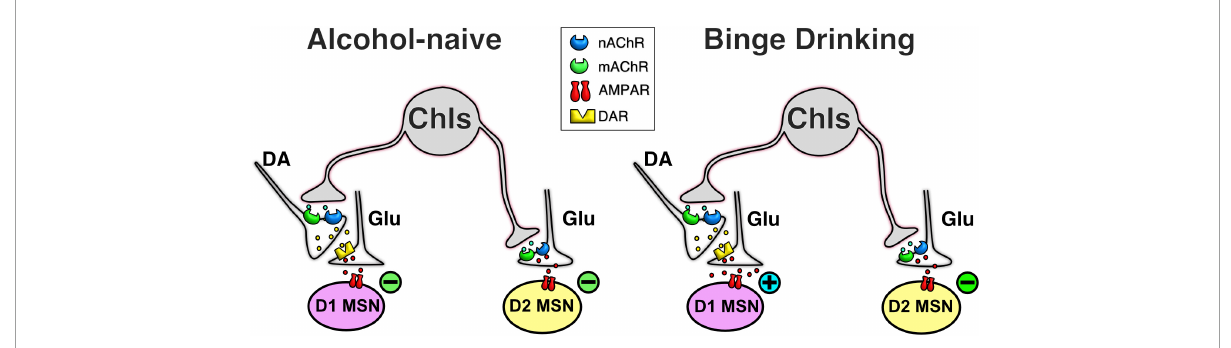
FIGURE8 Simplified schematic of ChI effect on glutamatergic neurotransmission in MSNs in naïve and alcohol binge drinking mice. In D1-MSNs of naïve mice, ChIs decrease glutamatergic neurotransmission presynaptically through the release of DA in D1-MSNs (top left cartoon) , an effect that is reversed in DID mice (top right cartoon) . In contrast, in D2-MSNs of naïve mice, ChIs directly control glutamate release from terminals synapsing on D2-MSNs (bottom left cartoon) , an effect that is unchanged in DID mice (bottom right cartoon)